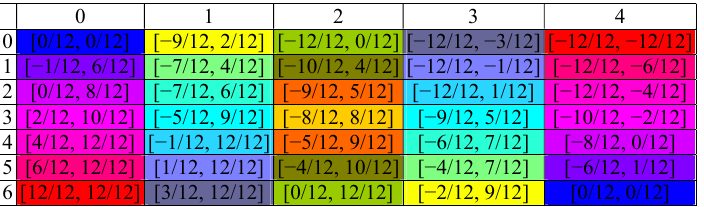
CIs at 5% risk of being in error for excess risk in x , y , m = 6, n = 4 group of binomial experiment configurations ( x